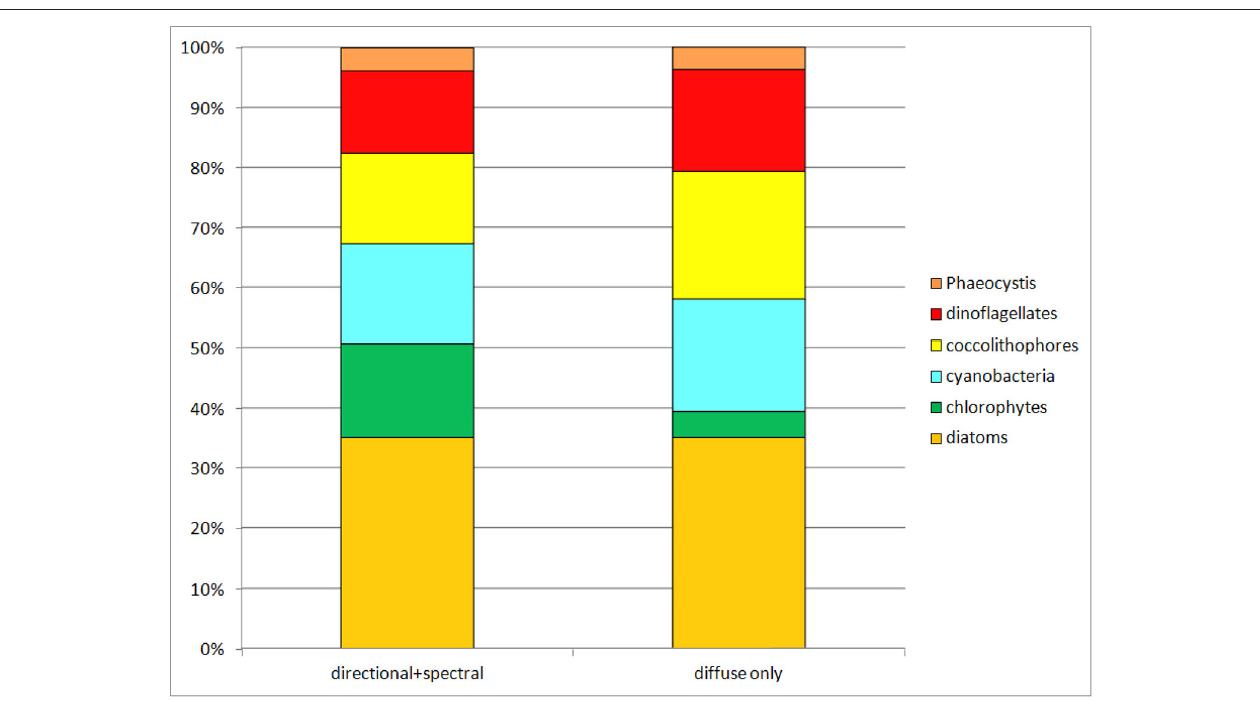
FIGURE 5 | Phytoplankton group relative abundances in the directional and spectrally-resolved model and the diffuse-only simulation. The direct-only simulation is not shown because it attenuates so much irradiance the results are clearly unrealistic.